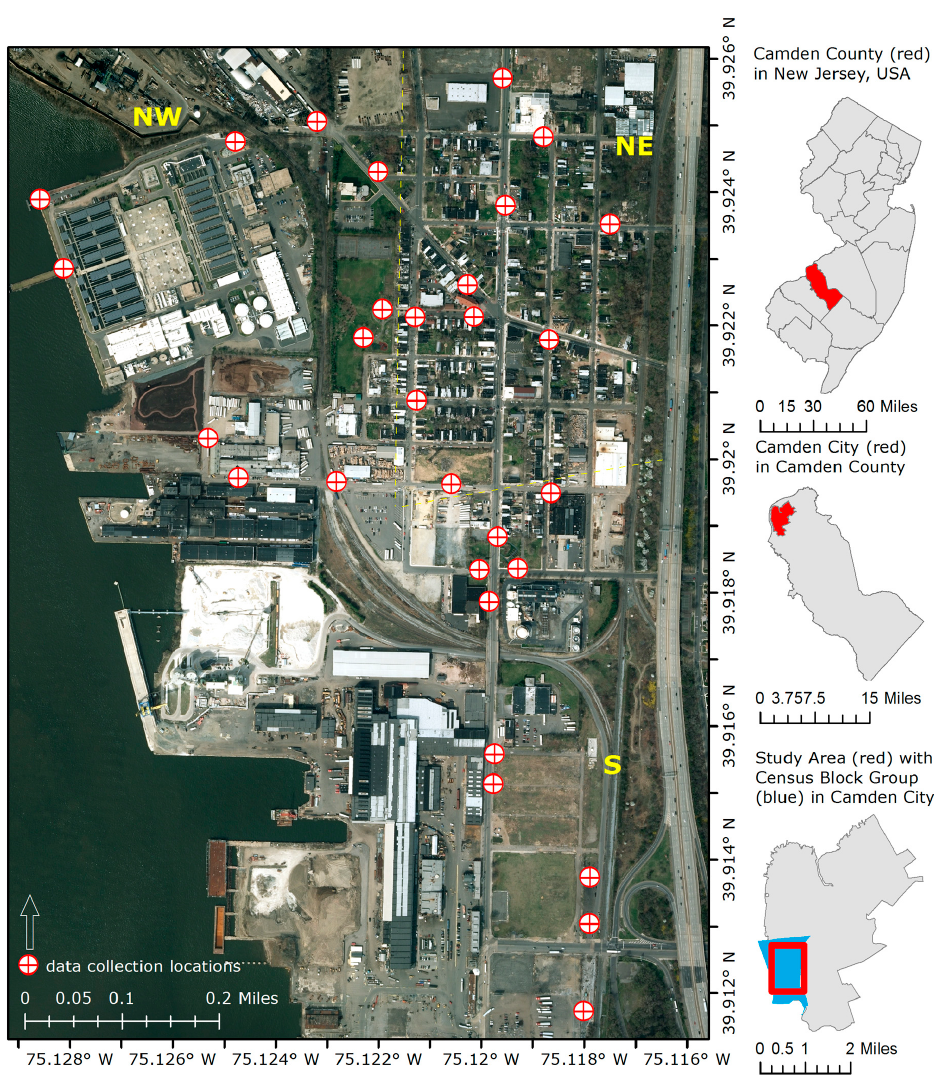
Figure 1. Field sample locations in the Waterfront South Neighborhood, Camden, NJ.